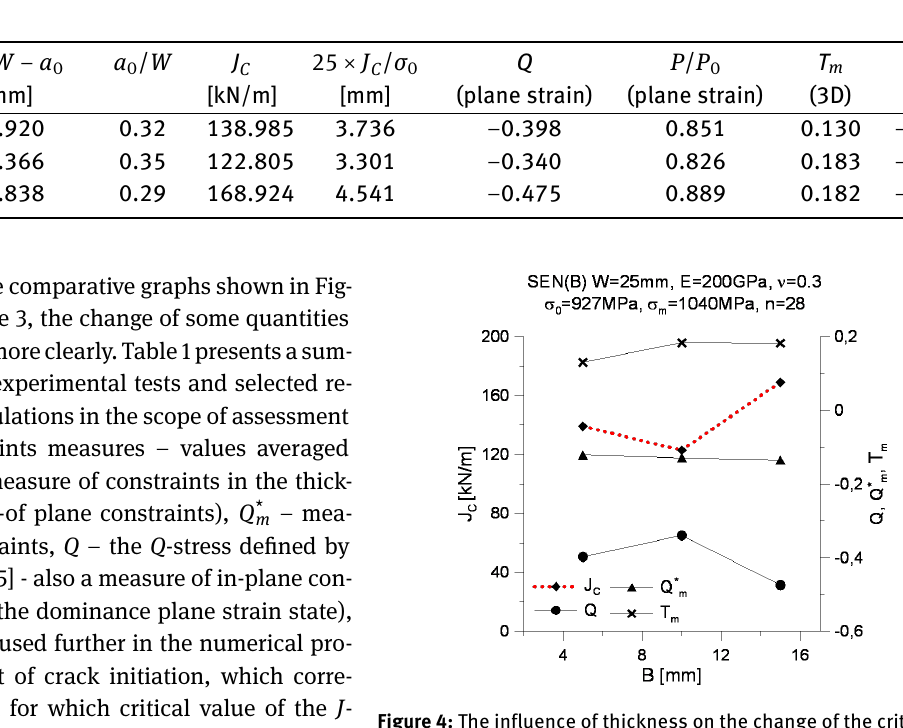
Figure 4: The influence of thickness on the change of the